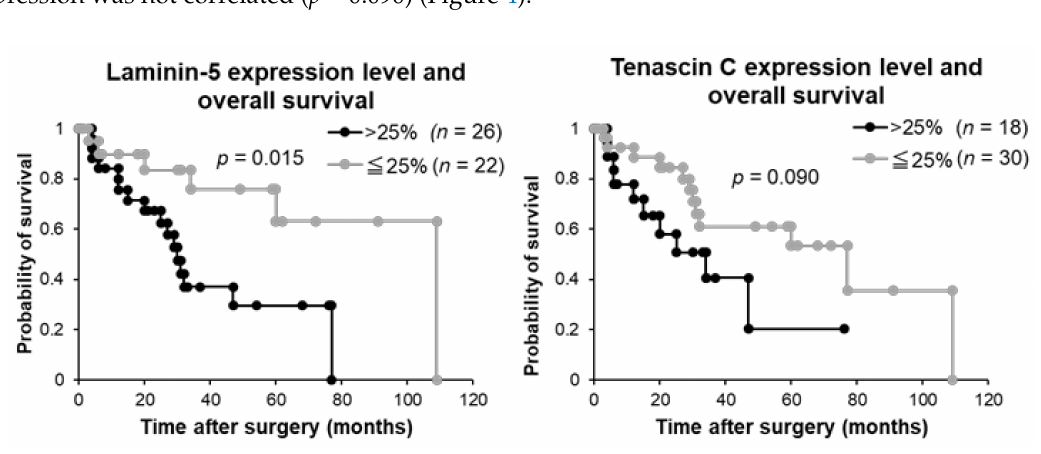
Figure 4. Laminin-5 and tenascin-C expression levels and overall survival analysis of patients with intrahepatic